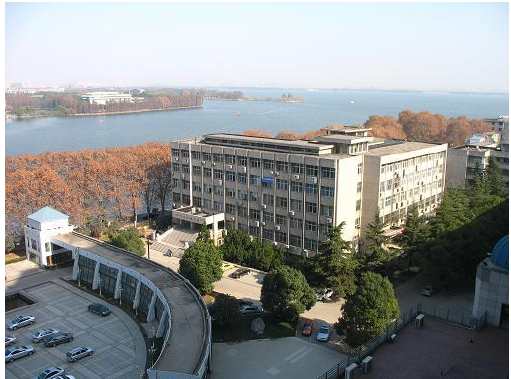
Figure 7a: Anoter test